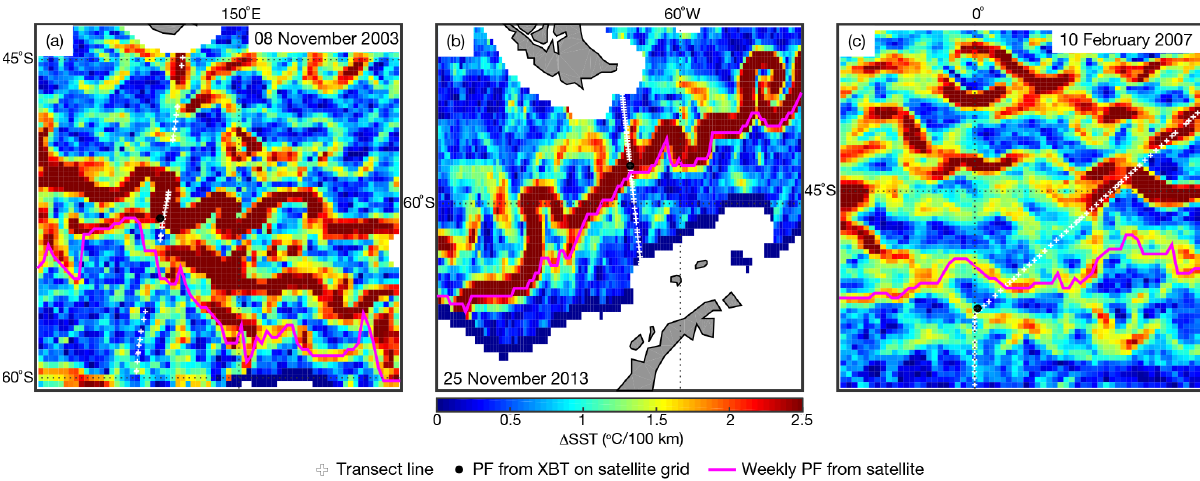
Figure 3. PF location identified from surface XBT data (timestamp indicated) overlain on the corresponding weekly satellite-estimated (cid:49) SST and PF realization in the (a) Australian, (b) Drake Passage, and (c) African sectors.